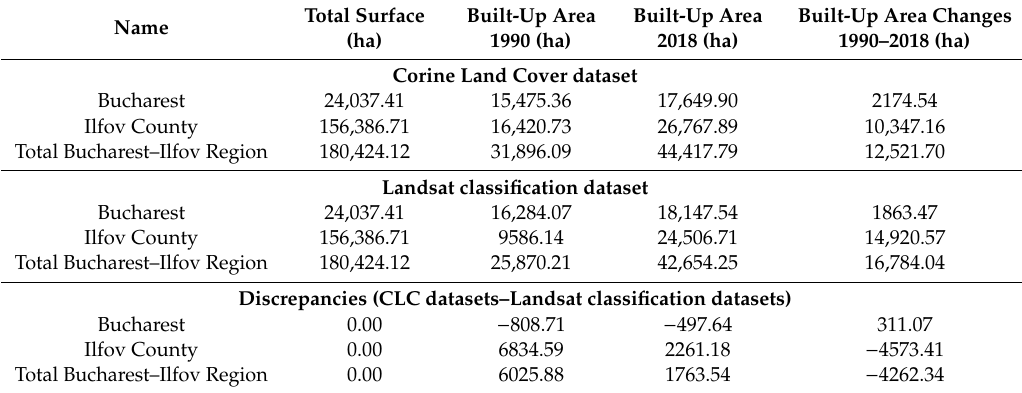
Table 2. Built-up area surfaces comparison in Bucharest–Ilfov Region (1990–2018), based on CLC and Landsat classification